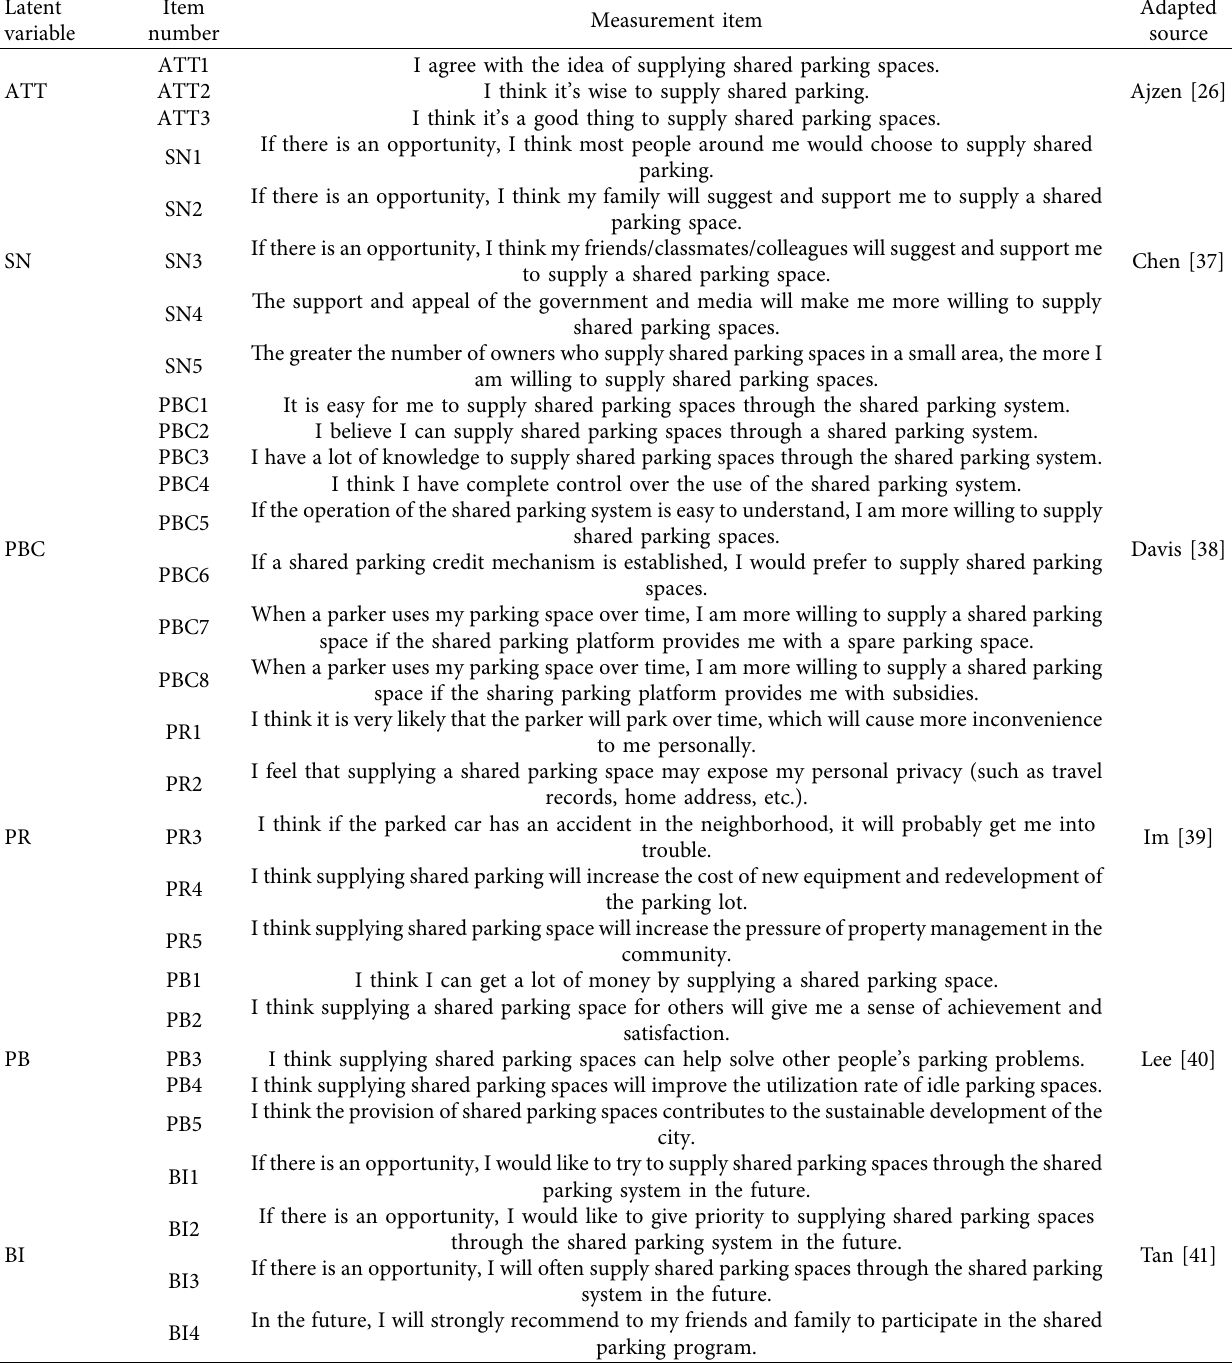
Table 1: Descriptive statistics of observed